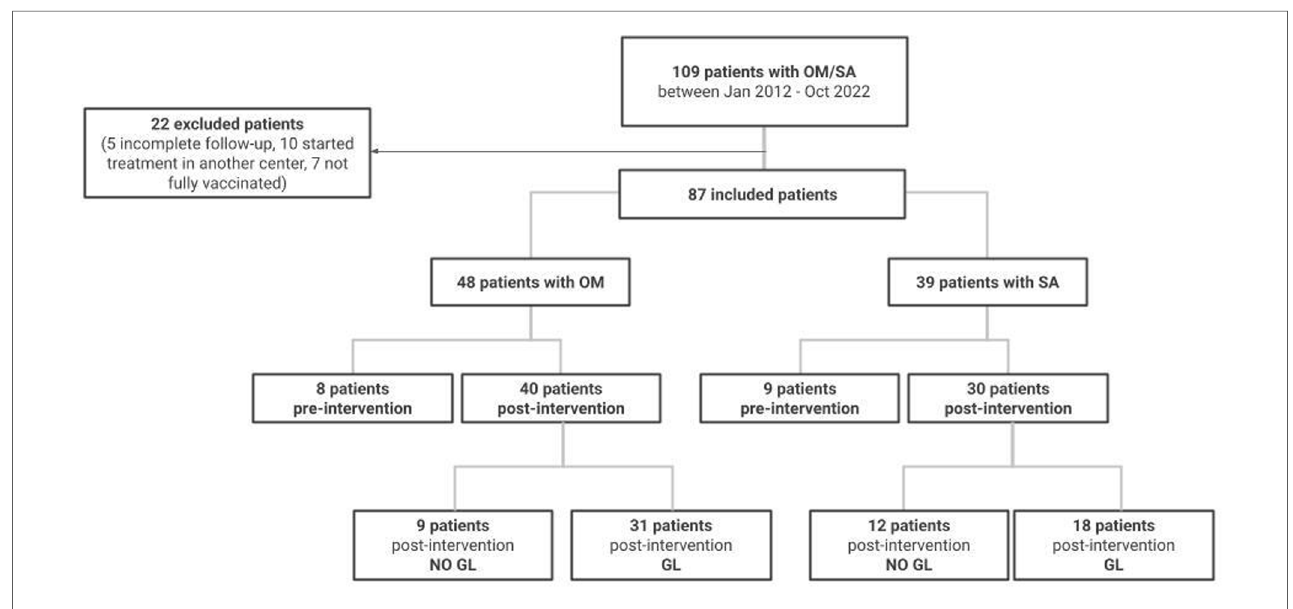
FIGURE 1 Study fl ow-chart. OM, osteomyelitis; SA, septic arthritis, GL, guidelines.